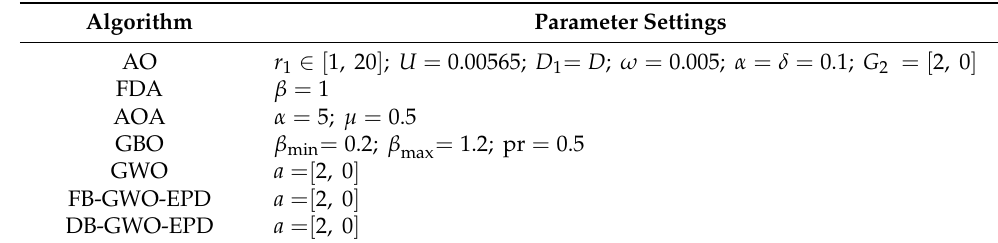
Table 4. Parameter settings of the DB-GWO-EPD and its competitive algorithms.